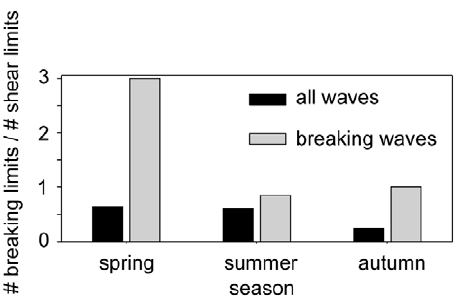
Figure 6. Ratio of the number of waves with amplitudes bounded by the breaking limit and waves with amplitudes bounded by shear limit depicted for different seasons (spring: April, May, summer: June – August, autumn: September, October). Black bars correspond to all waves, grey bars to waves simulated to break ( A obs /A lim $